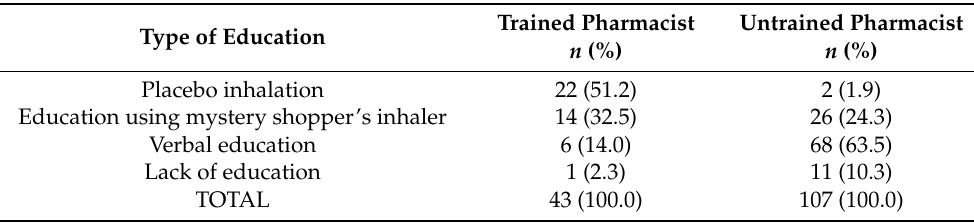
Table 2. Type of conducted education, determined by the pharmacist’s level of training ( n = 150, p < 0.0001 *). Type of